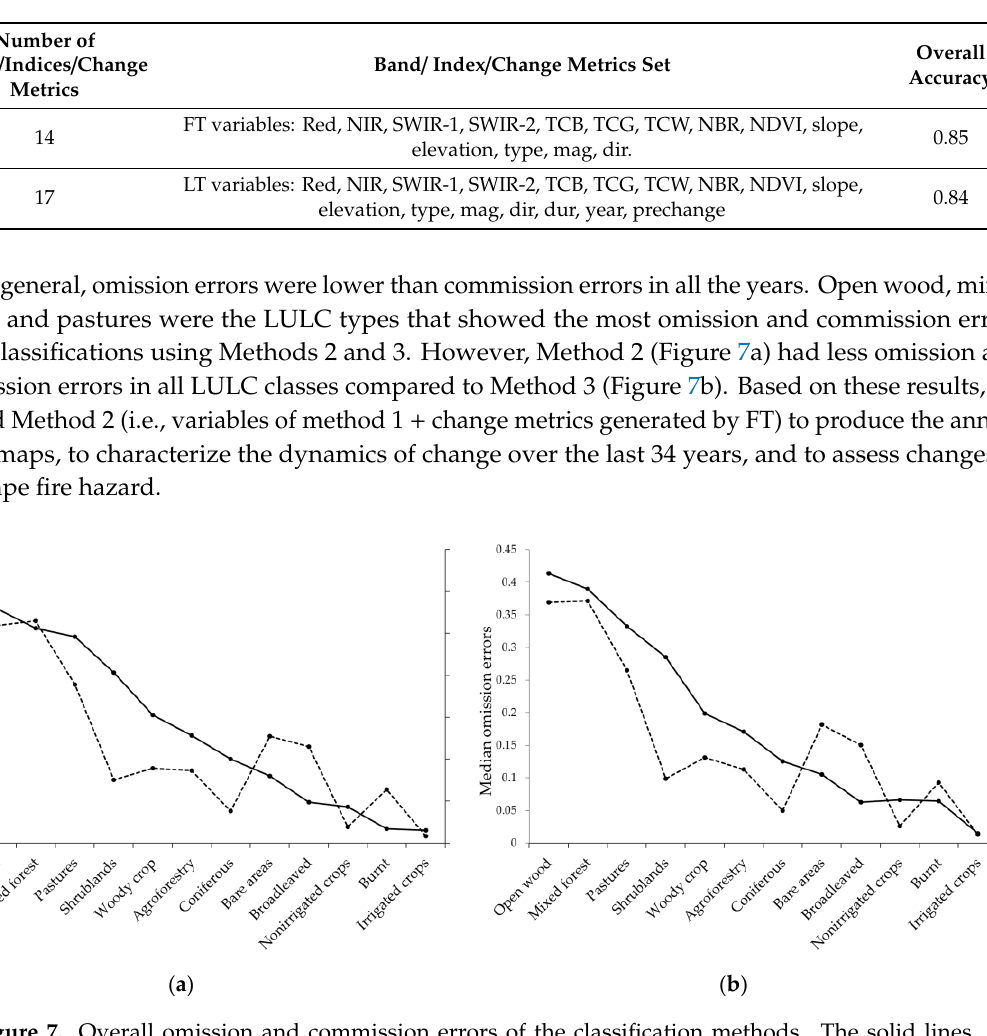
Figure 7. Overall omission and commission errors of the classification methods. The solid lines represent the median omission error and the dotted lines represent the median commission errors. ( a ) Method 2 (variables of Method 1 + change metrics generated by FT) ( b ) Method 3 (variables of Method 1 + change metrics generated by LT).